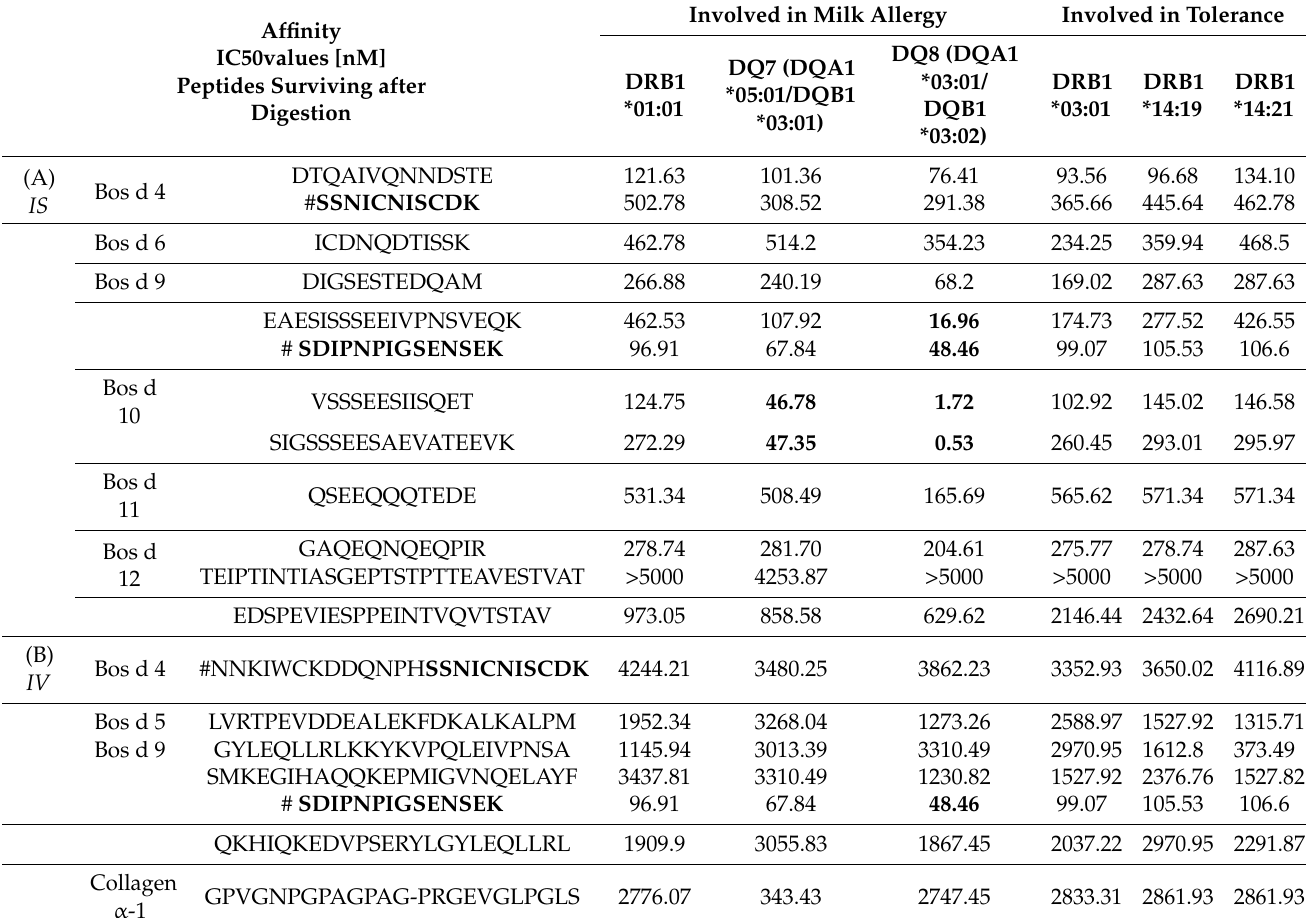
Table 4. IS tested affinity of obtained both (A) IS and (B) IV peptides to selected, defined MHC II according the IEDB Analysis